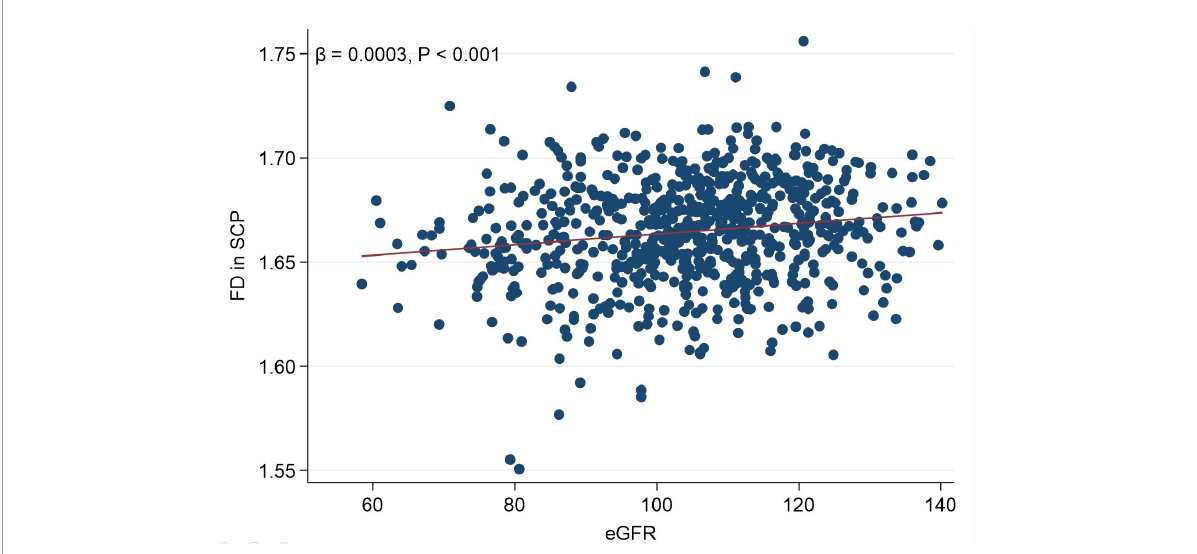
FIGURE2 Scattergram showing linear correlation between fractal dimension in the superficial capillary plexus and estimated glomerular filtration rate.